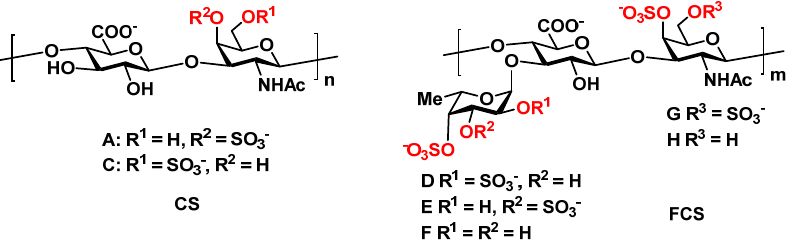
Figure 1. Structures of chondroitin sulfate ( CS ) from the fish Salmo salar [22] and fucosylated chon- droitin sulfate ( FCS ) from the sea cucumber Apostichopus japonicus